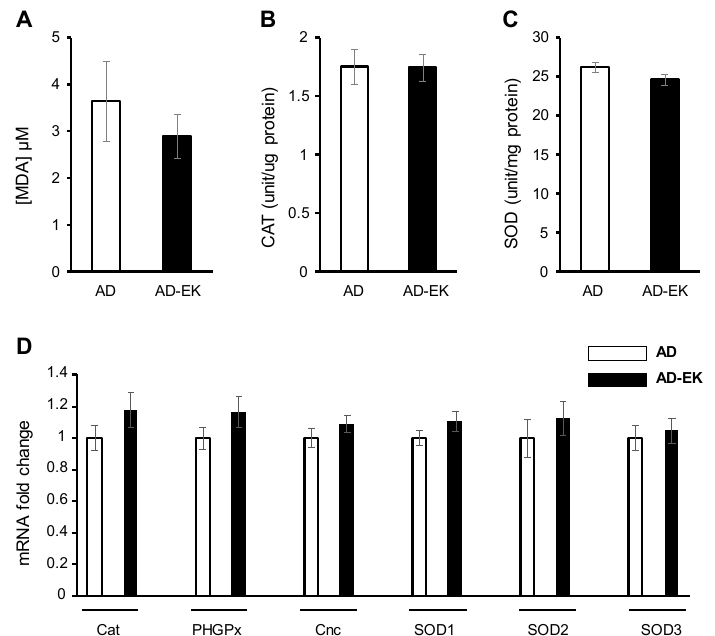
Figure 4. Ergosta-7,9(11),22-trien-3 β -ol did not modulate oxidative stress in an AD fruit fly model. ( A ) Lipid peroxidation (MDA) assay. ( B ) Catalase assay. ( C ) SOD assay. ( D ) mRNA expression of oxidative stress genes. Error bar stands for standard error of mean. AD denotes Alzheimer’s model. AD-EK denotes Alzheimer’s model treated with ergosta-7,9(11),22-trien-3 β -ol (EK100).